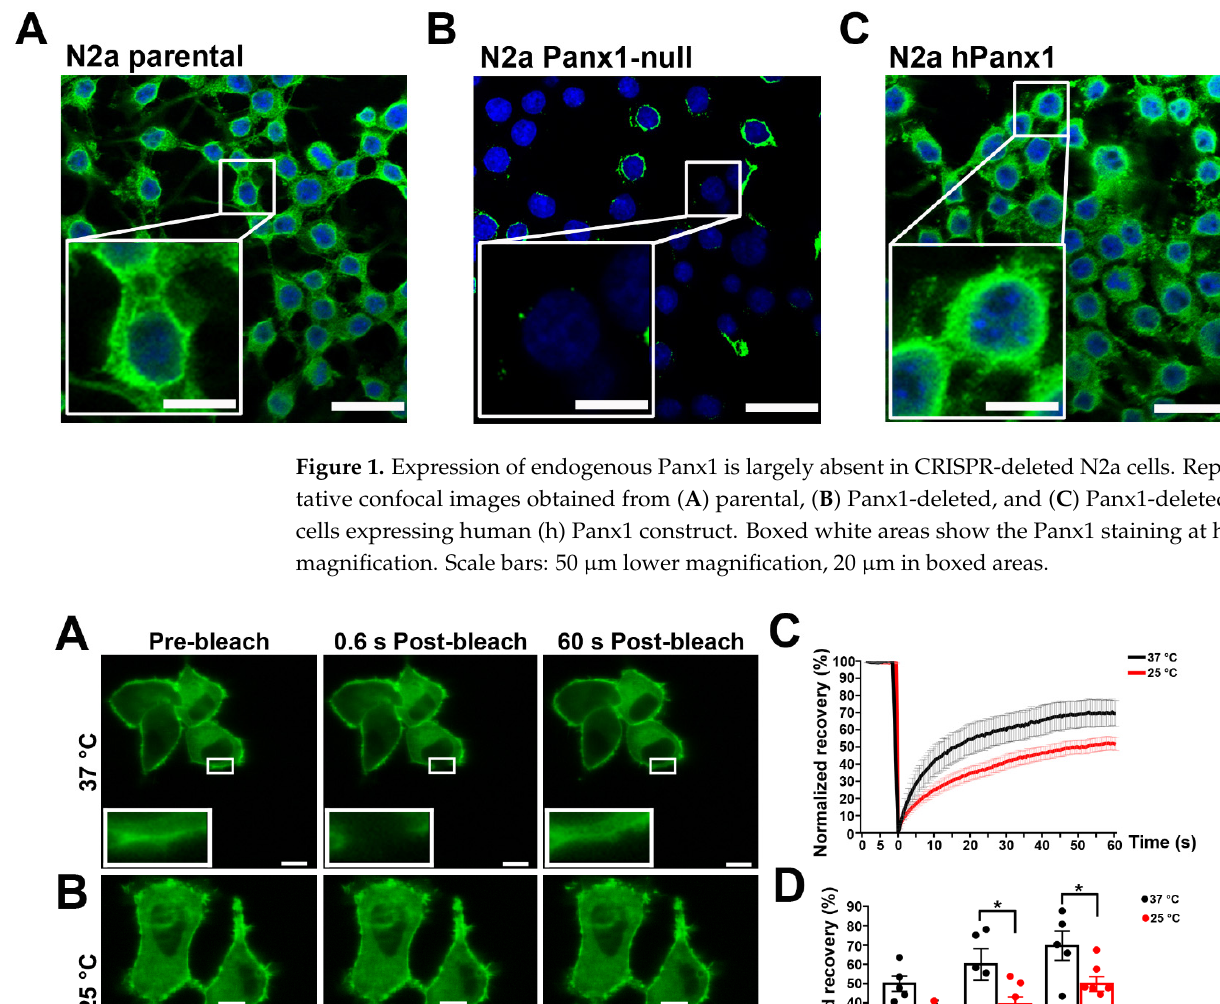
Figure 1. Expression of endogenous Panx1 is largely absent in CRISPR-deleted N2a cells. Repre- sentative confocal images obtained from ( A ) parental, ( B ) Panx1-deleted, and ( C ) Panx1-deleted N2a cells expressing human (h) Panx1 construct. Boxed white areas show the Panx1 staining at higher magnification. Scale bars: 50 µm lower magnification, 20 µm in boxed areas.